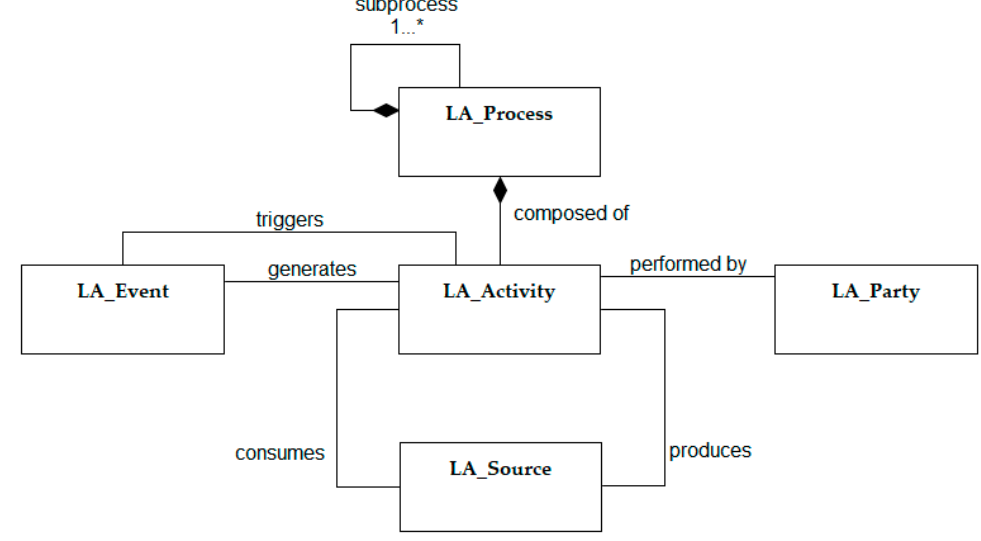
Figure 5. Process model linked to the LADM. Source: Own compilation.